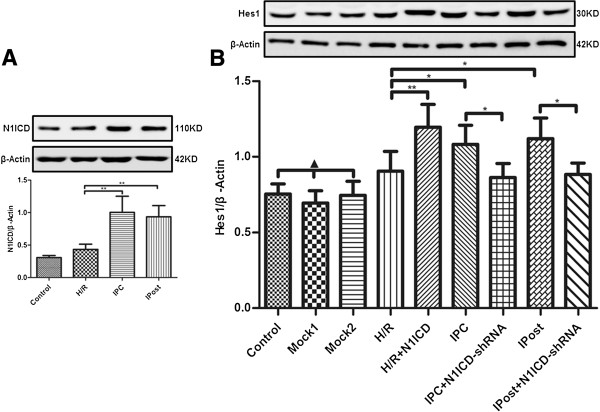
Notch1 signaling is activated in H9c2 cells exposed to IPC and IPost. A, N1ICD level was upregulated in IPC and IPost. B, Hes1 level was regulated by H/R, IPC and IPost with or without LV-N1ICD/LV-N1ICD-shRNA infection. Data were presented as mean±SD, n=3. Mock1 indicated cells infected with empty vector, Mock2 indicated cells infected with vector containing nonspecfic sequences. ▲P>0.05, *P<0.05, **P<0.01.